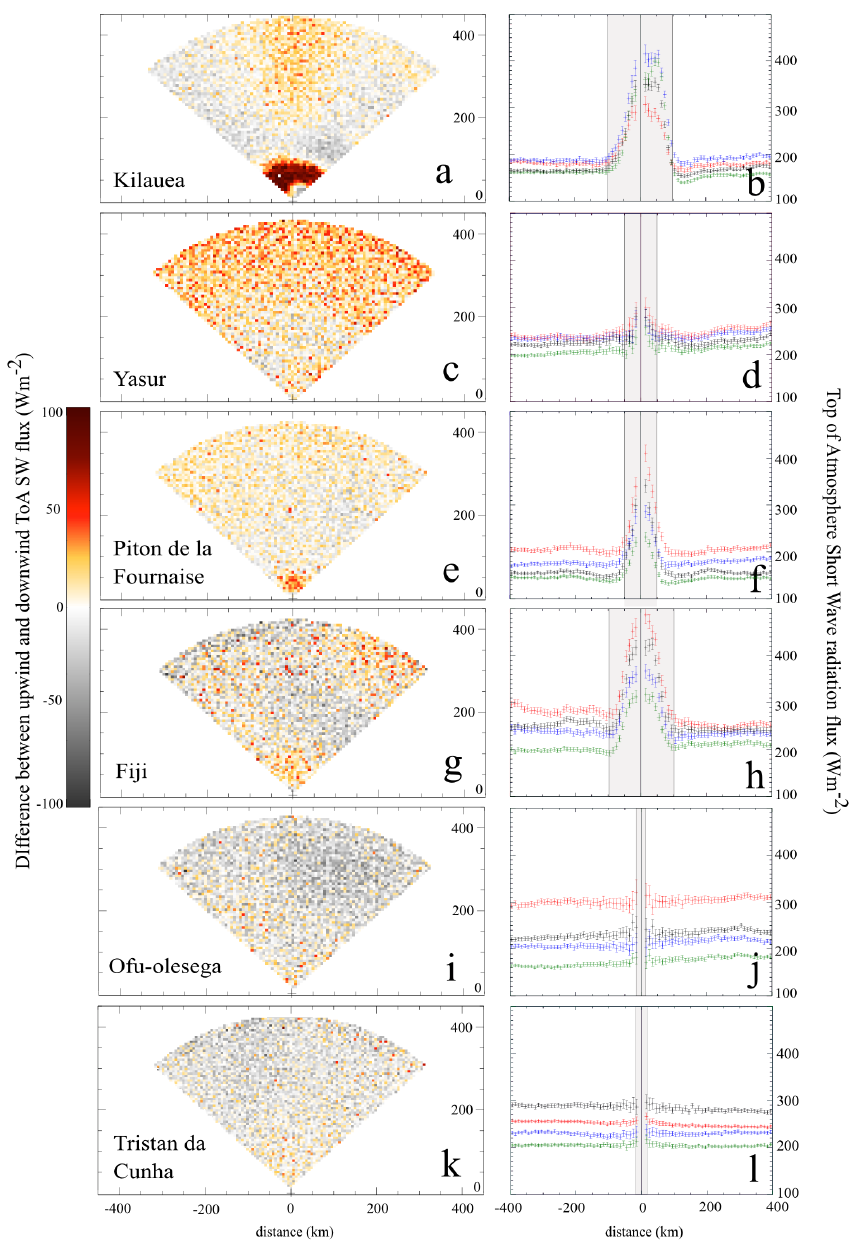
Figure 5. Scatter plots showing the difference between upwind and downwind Top of Atmosphere Short-Wave flux (a, c, e, g, i, k) for volcanoes and ‘controls’. Positive values indicate higher upward SW flux downwind of the volcano. Profiles (b, d, f, h, j, l) indicate seasonal average SW fluxes for arcs of π at equal distance upwind and downwind from the volcano or island. December–February is red, March–May is blue, June–August is green and September–November is